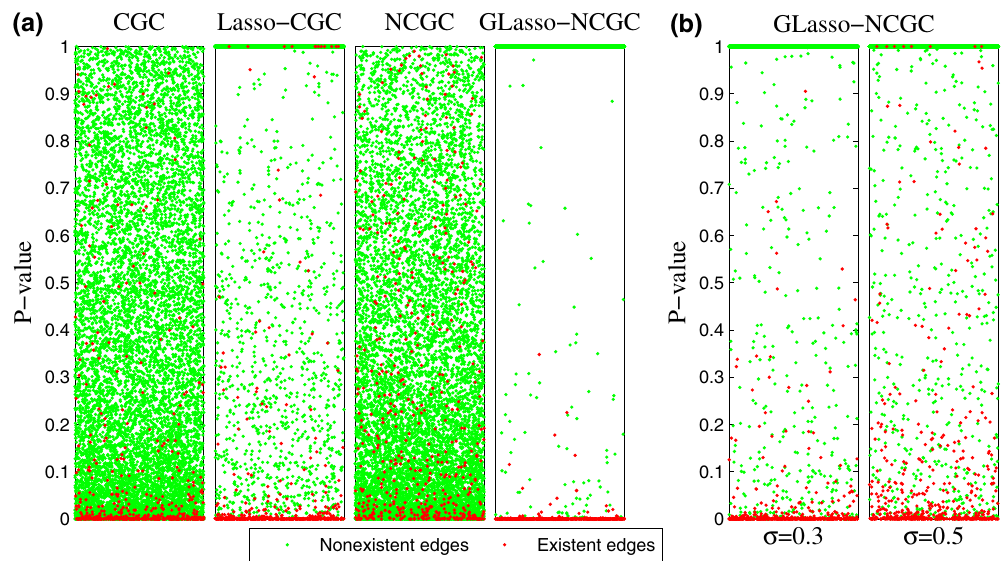
Figure 9. Simulation of GRN model on SW network ( N = 100, k = 5, M = 400). ( a ) Reconstructed values of elements in different inferred matrixes with noise  . (0,0 1 ) 2 . ( b ) Reconstructed values of elements in recovered matrixes by GLasso-NCGC with noise . (0,0 3 ) 2  and . (0,0 5 ) 2 